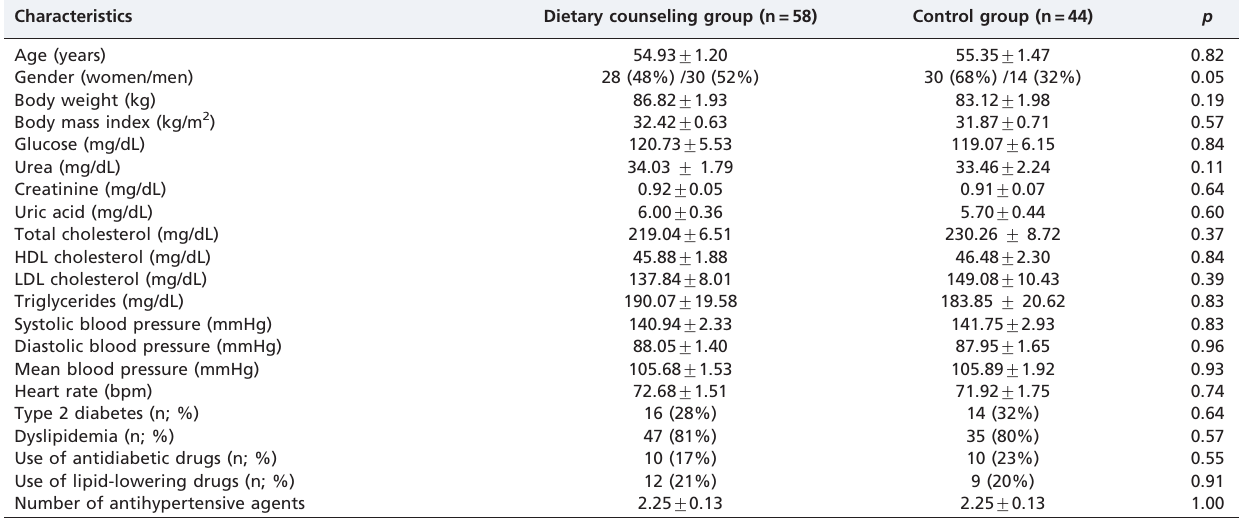
Table 1 - Baseline characteristics of participants according to dietary counseling.